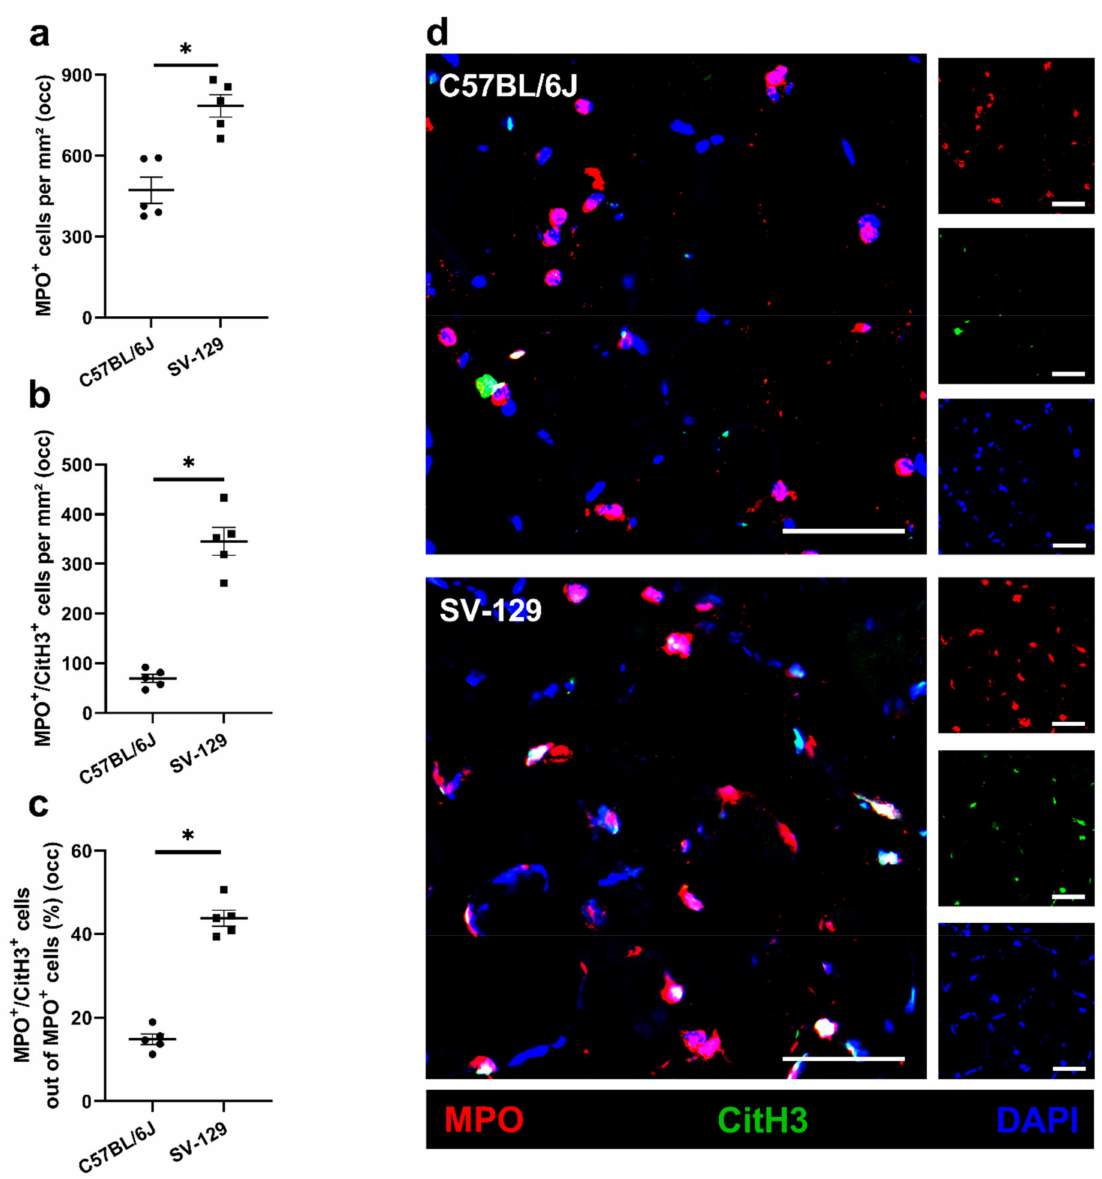
Figure 4. Compared to SV-129 mice, accumulation of neutrophils and neutrophil extracellular trap (NET) formation is diminished in C57BL/6J mice under ischemic conditions. Scatter plots display the number of ( a ) neutrophils (MPO + (myeloperoxidase)/DAPI + ) per mm 2 , ( b ) neutrophil extracellular traps (MPO + /CitH3 + (citrullinated histone H3)/DAPI + ) per mm 2 , and ( c ) the percentage of NETs/neutrophils in occluded (occ) ischemic gastrocnemius muscles isolated from C57BL/6J and SV-129 mice 24 h after femoral artery ligation (FAL). A defined ischemic area (0.86 mm 2 ) of muscle tissue was analyzed per mouse. Data are means ± S.E.M., n = 5 per group. * p < 0.05 ( C57BL/6J vs. SV-129 ) by unpaired, two-sided Student’s t -test. ( d ) Representative immunofluorescence staining of ischemic gastrocnemius muscles of C57BL/6J (top) and SV-129 mice (bottom) collected 24 h after FAL. Cells were stained with an antibody against MPO (red), CitH3 (green), and DAPI (blue) to label nucleic DNA. Scale bars: 50 µ